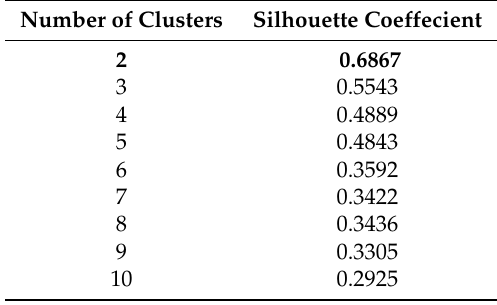
Table 1. The number of clusters received for the iris dataset by the silhouette